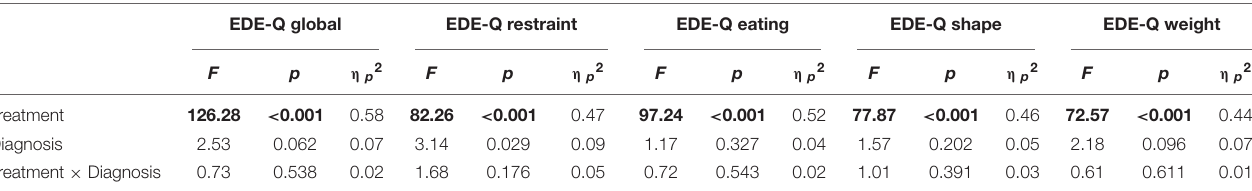
TABLE 2 | Tests of main effects and interaction of treatment (intake, discharge) and diagnosis on ED